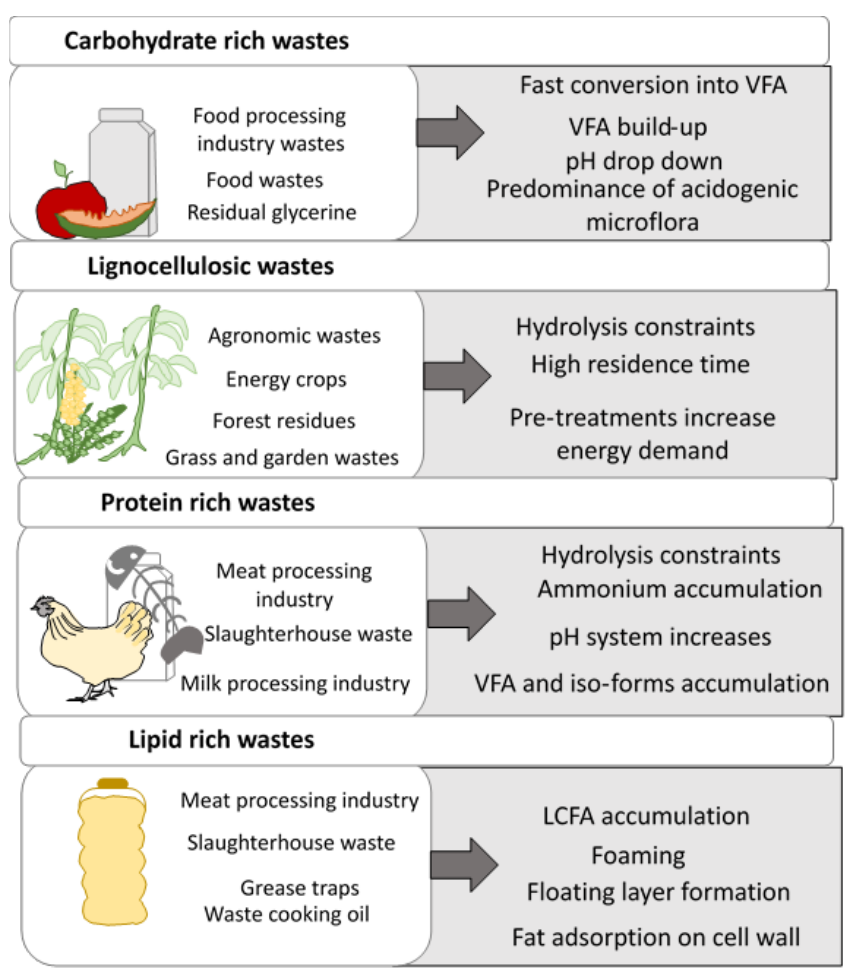
Figure 2. Co-substrates used in anaerobic digestion and expected problems in reactor dynamics.